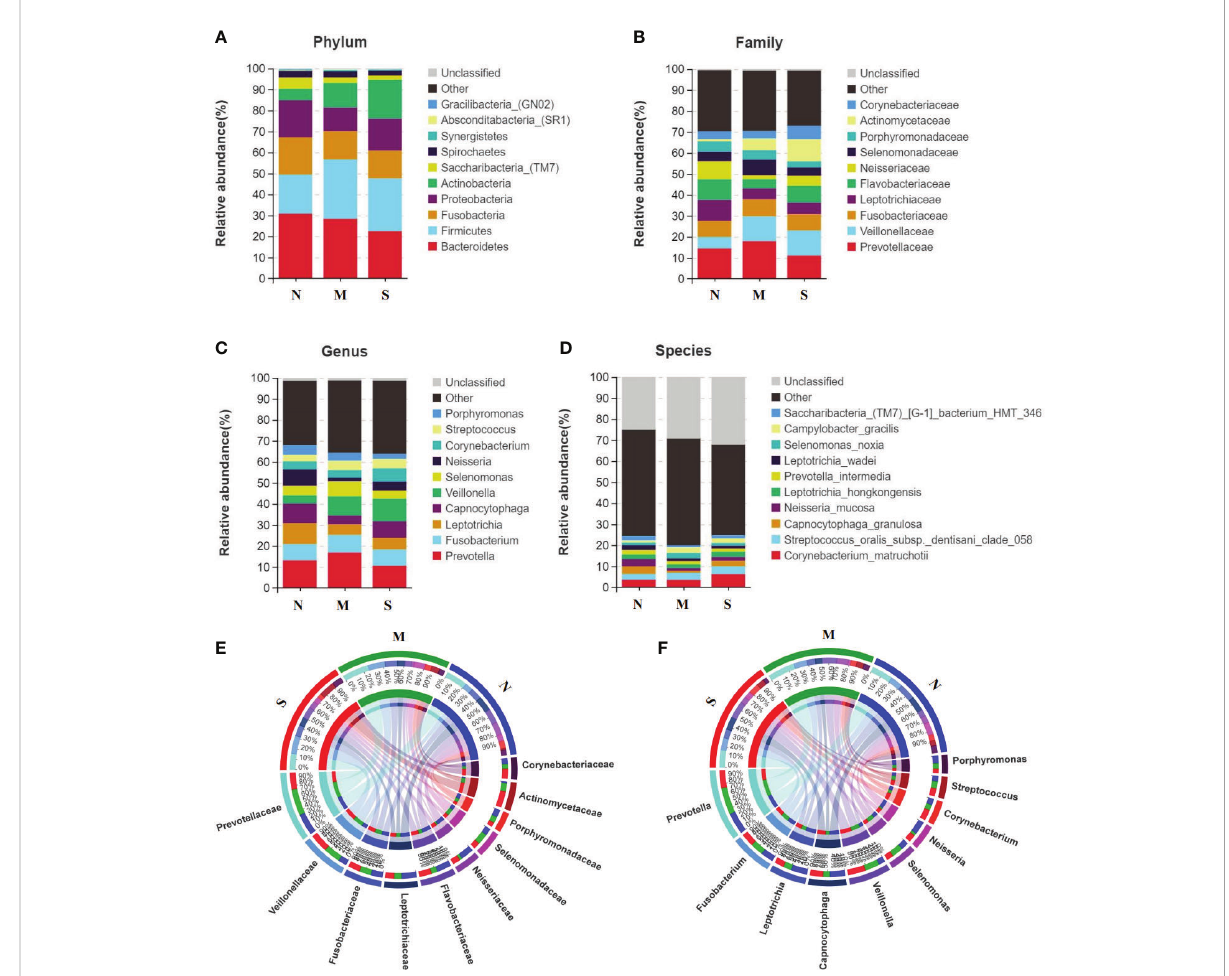
FIGURE 3 Oral microbiota composition of all three groups. (A-D) Average composition of bacterial community at the phylum, family, genus and species levels represent the top 10 dominant species. (E, F) Circos circle diagram was used to show the corresponding relationship between sample groups and species, re fl ecting the composition proportion and distribution of dominant species among different groups at family level (E) and genus level (F)